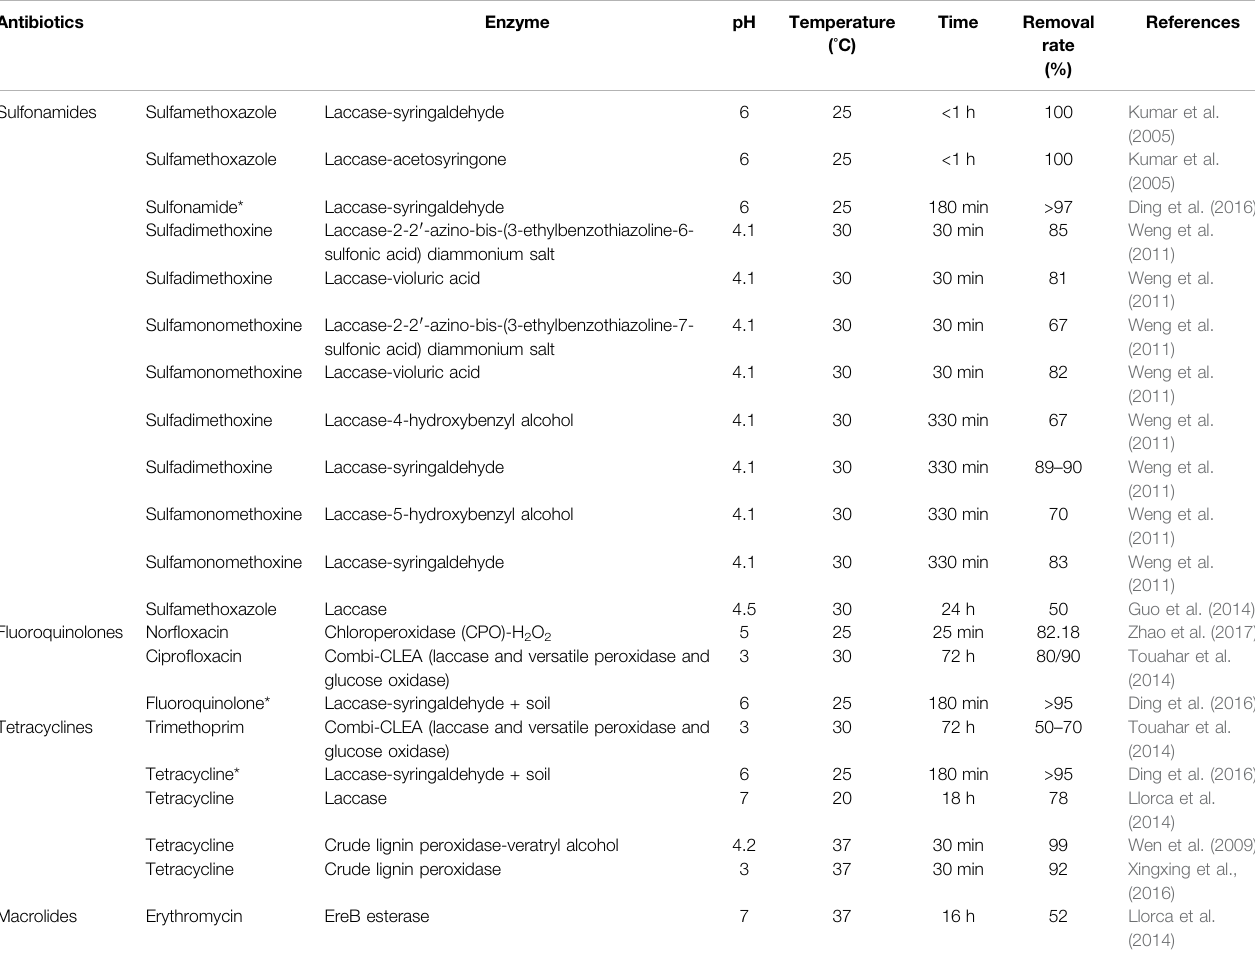
TABLE 10 | Antibiotic enzyme systems.